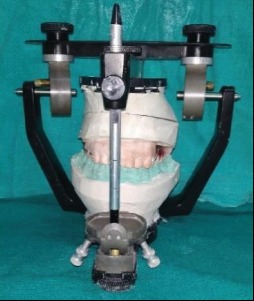
Teeth arrangement.